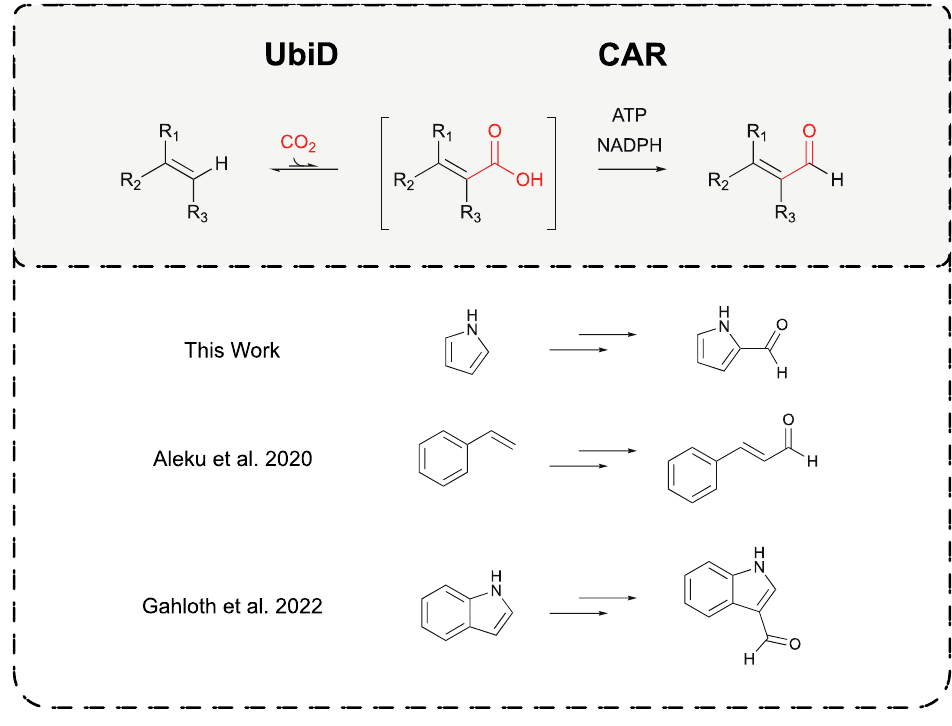
Figure 10. Application of combined UbiD-CAR biocatalytic reactions for the production of aldehydes from terminal alkanes and heteroaromatics. Highlighting successes to date in utilising this system in the production of pyrrole-2-carbaldehyde from pyrrole, as presented within this work, the production of cinnamaldehyde from styrene [7], and the production of indole-3-carbaldehyde from indole [21].